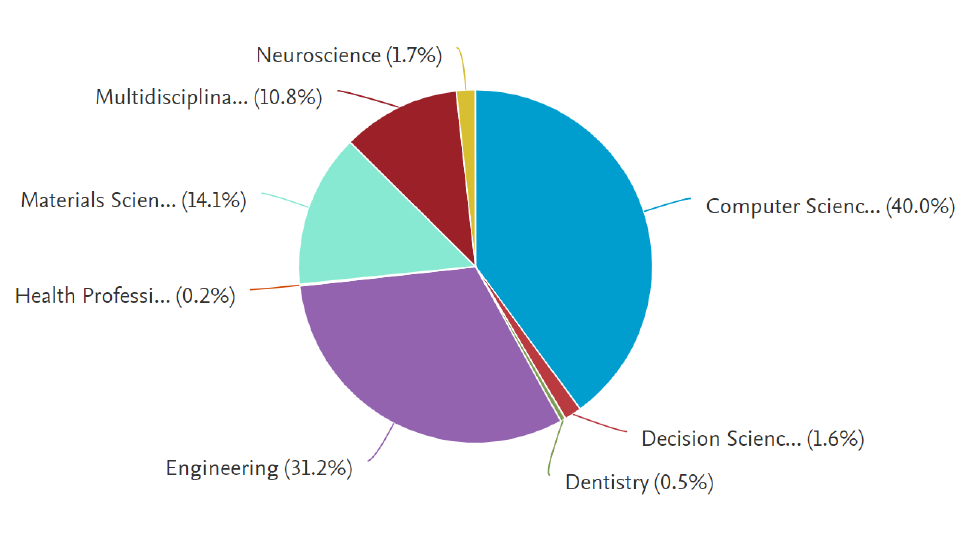
Figure 5. Distribution of articles by subject